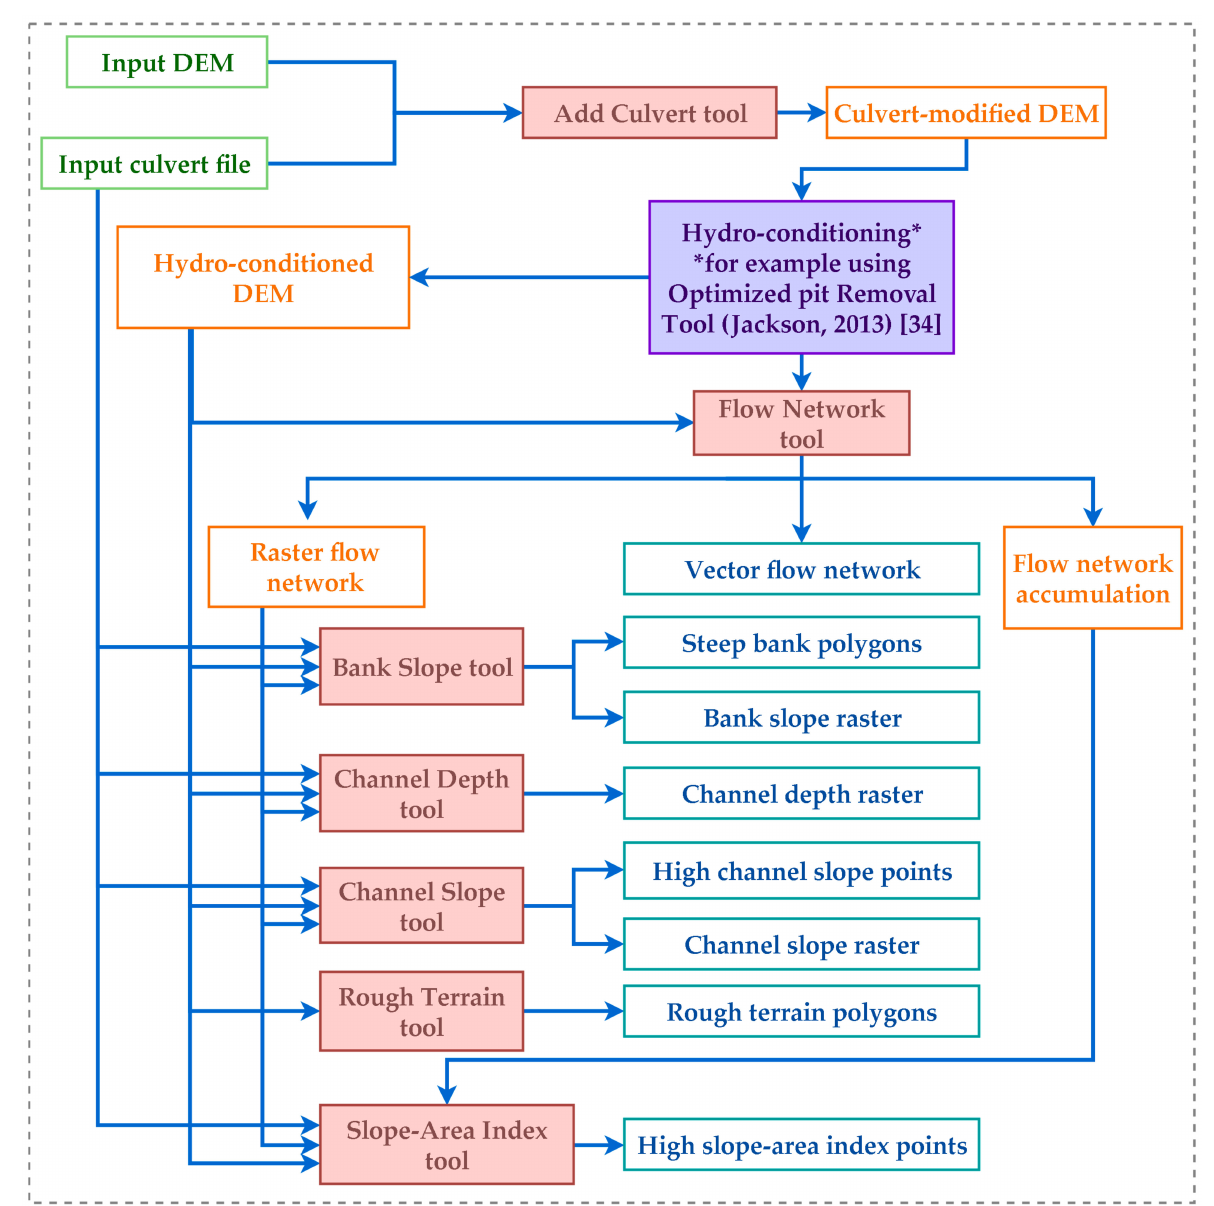
Figure 1. The automated workflow of the geomorphology toolbox developed by the U.S. Geological Survey (USGS)